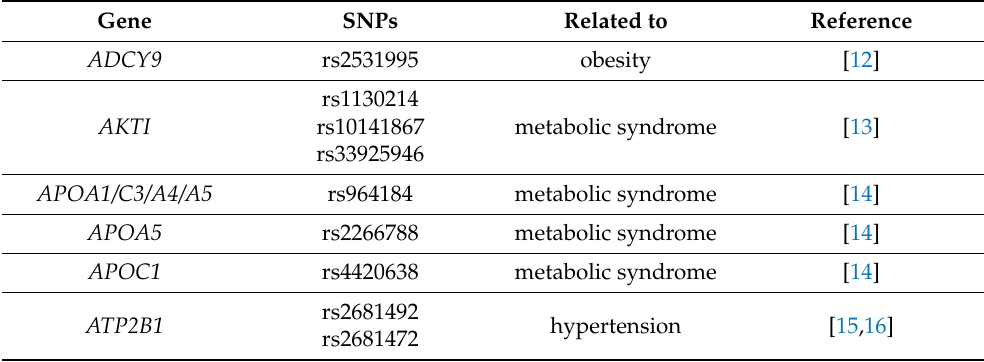
Table 1. Review of SNPs related to hypertension, obesity or metabolic syndrome. * Association observed in